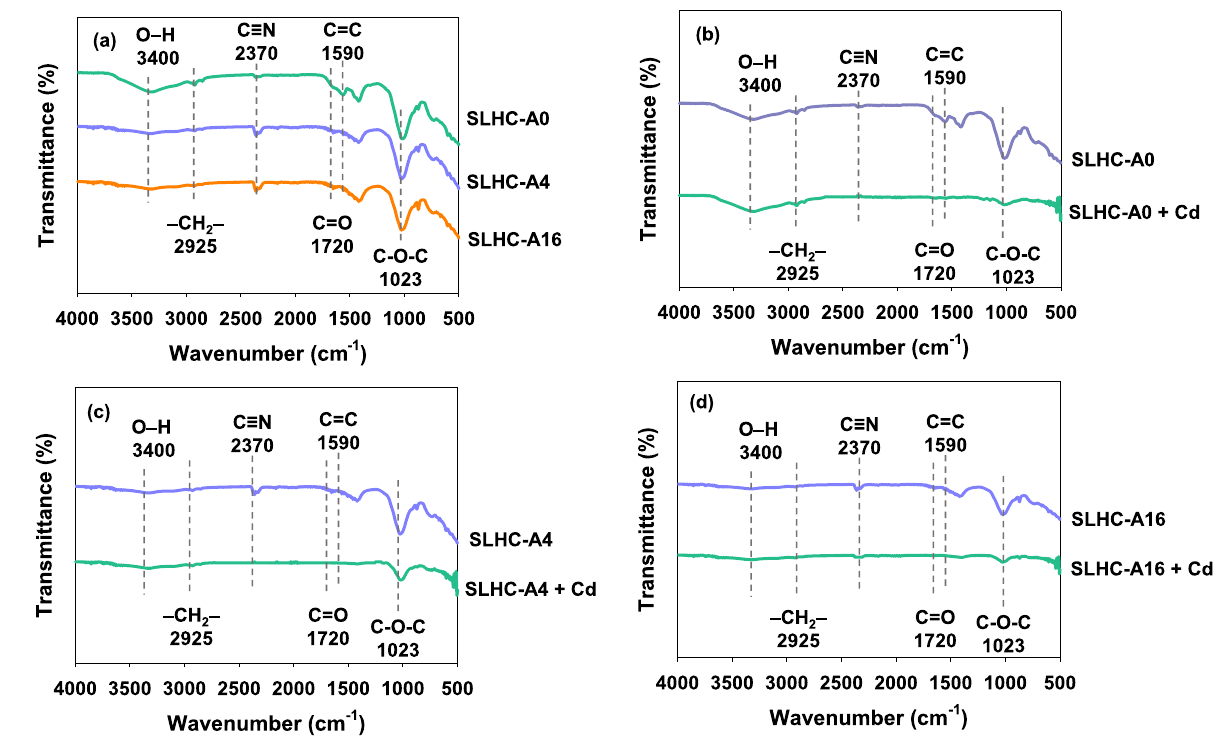
Fig. 1 Fourier transformed infrared spectra of different hydrochars. a SLHC series hydrochars. b SLHC-A0 before and after sorption of Cd. c SLHC-A4 before and after sorption of Cd. d SLHC-A16 before and after sorption of Cd. SLHC-A0 represents fresh sludge-derived hydrochar. SLHC-A4 represents 4-month aged sludge-derived hydro-